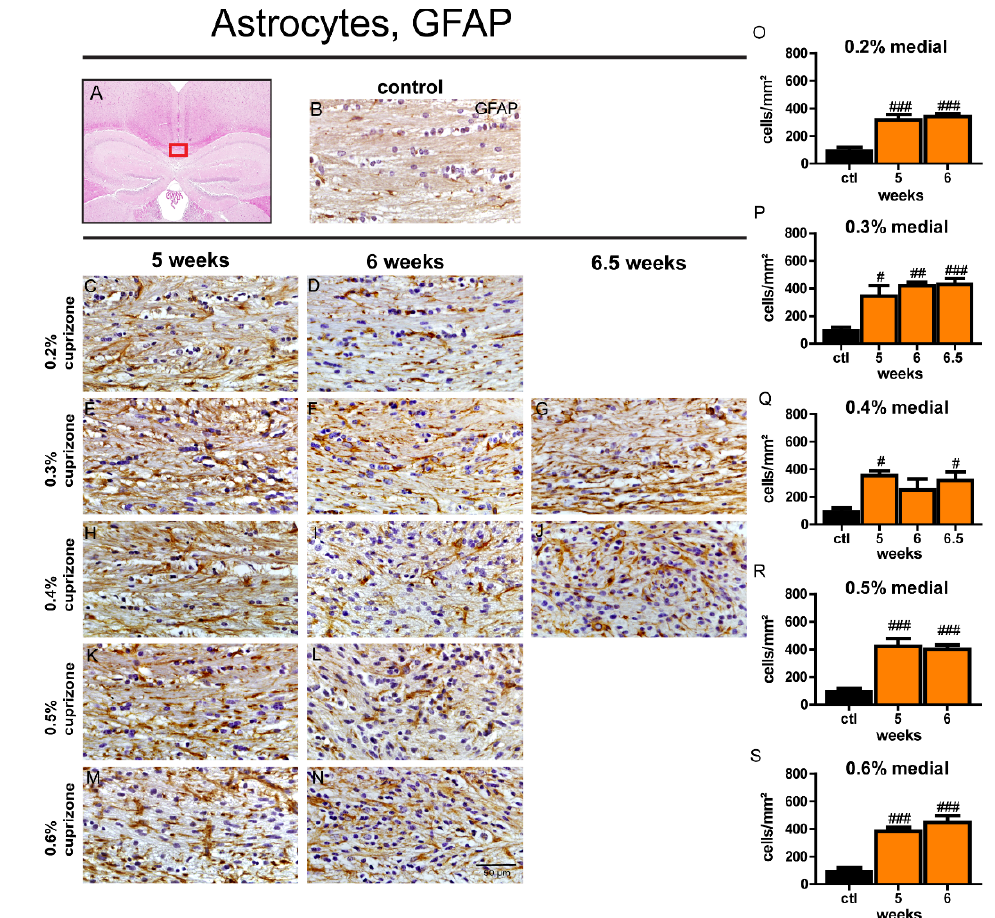
Figure 4. Astrocytosis in the medial corpus callosum of aged mice after different cuprizone treatment protocols. The boxed area represents the medial part of the corpus callosum which was examined ( A ). An exemplary picture shows a brain section of a control animal stained for GFAP ( B ). Representative images of GFAP-stained sections ( C – N ) depict astrocyte hypertrophy and hyperplasia during demyelination in the central corpus callosum of aged mice after cuprizone treatment with different concentrations (0.2–0.6% cuprizone) for different treatment periods (5, 6, or 6.5 weeks). Graphs show the number of GFAP-positive astrocytes/mm 2 in the midline of the corpus callosum in aged animals ( O – S ). Bars represent mean + SEM. Effects between different investigated time points are indicated by asterisks and effects in comparison to control are indicated by hashmarks (*/ # p < 0.05; **/ ## p < 0.01; ***/ ### p < 0.001). Ctl. = control; 5, 6, or 6.5 weeks = feeding period of cuprizone for respective duration. N = 5–6 animals per group.